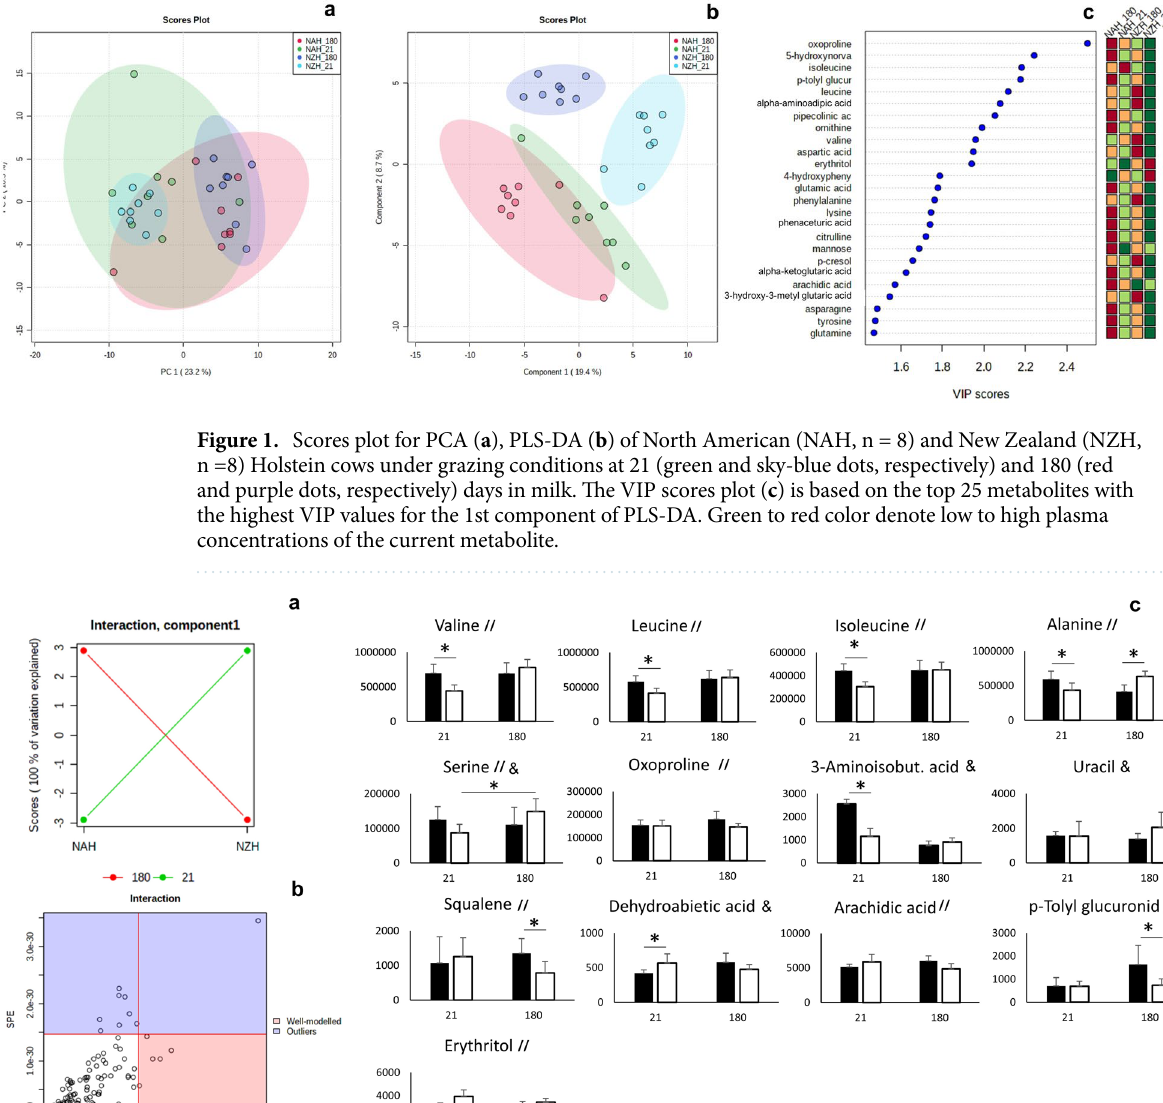
Table 3. Metabolic pathways differentially expressed accross lactation stages (21 vs. 180 days in milk; DIM) or by genetic strains (North American Holstein vs. New Zealand Holstein; NAH vs. NAZ) at 21 days in milk. Total compounds, hits and pathway impacts are presented along with P-statistics. 1: Total metabolites theoretically considered by the Bos taurus KEGG database for the current metabolic pathways. 2: Metabolites efectively quantified in the current study and belonging to the identified pathway. 3: Raw-P and FDR -adjusted P values obtained with the Global Test. 4: Topological analysis of impact of the current metabolic pathway.